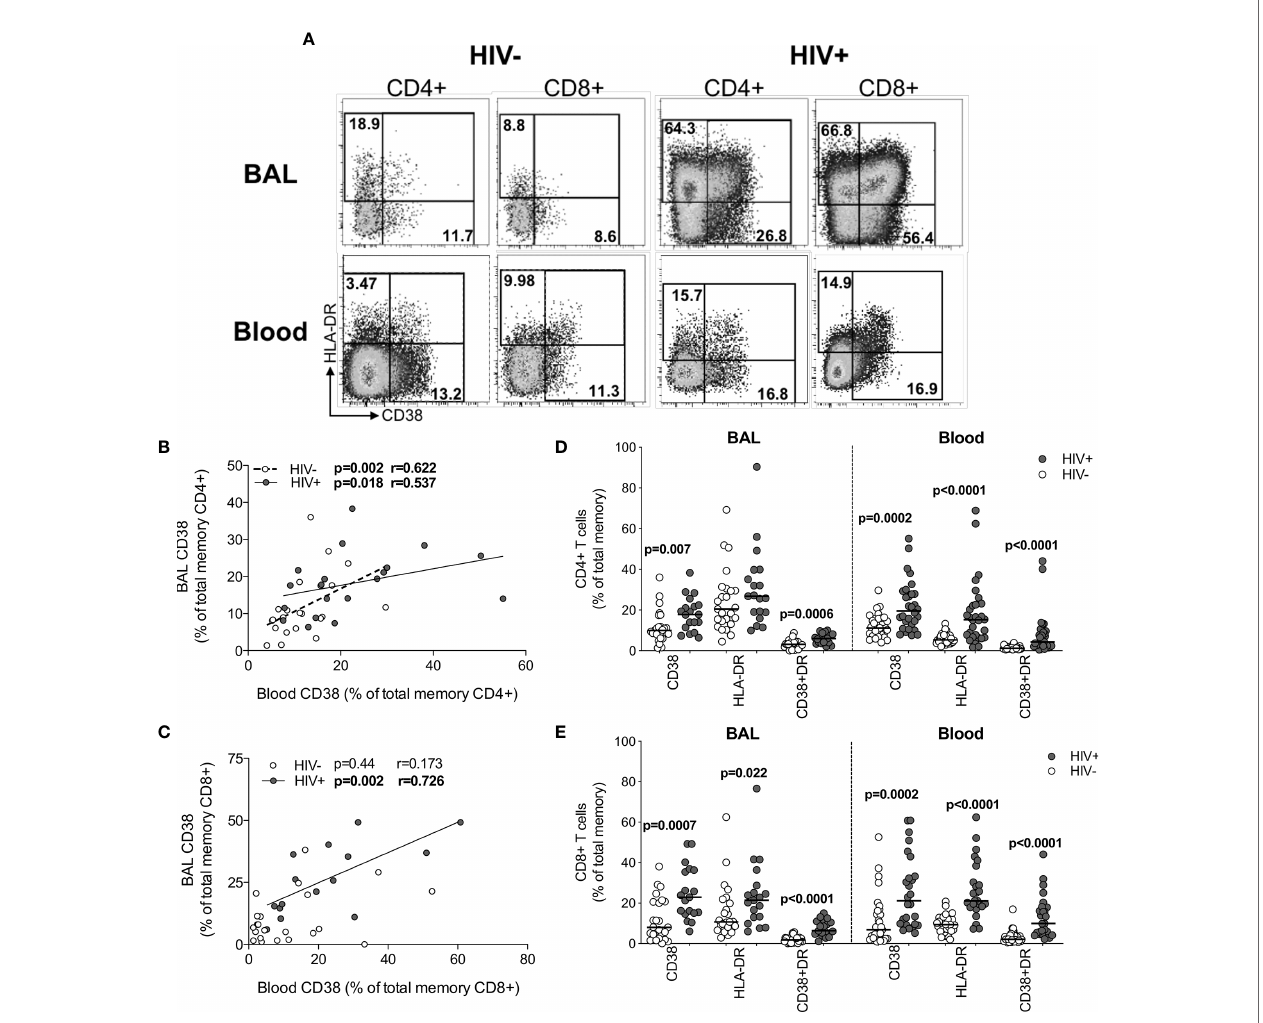
FIGURE 5 | T cell activation in BAL and blood. (A) Representative fl ow cytometry plots of HLA-DR and CD38 expression on T cells in BAL and blood of HIV- infected and uninfected participants. (B) The association between CD4+ T cells expressing CD38 in blood and BAL of HIV-uninfected (n=22) and infected (n=15) individuals. (C) The association between CD8+ T cells expressing CD38 in blood and BAL of HIV-uninfected (n=22) and infected (n=15) individuals. (D) CD38 and HLA-DR expression on CD4+ T cells in blood and BAL of HIV-uninfected (n=31 and n=25, respectively) and infected (n=30 and n=19, respectively) individuals. (E) CD38 and HLA-DR expression on CD8+ T cells in blood and BAL of HIV-uninfected and infected individuals. Each dot represents an individual. Open circles represent HIV-uninfected individuals and fi lled circles represent HIV-infected individuals. Statistical comparisons were performed using the non-parametric Mann Whitney, Wilcoxon matched pairs and Spearman correlation